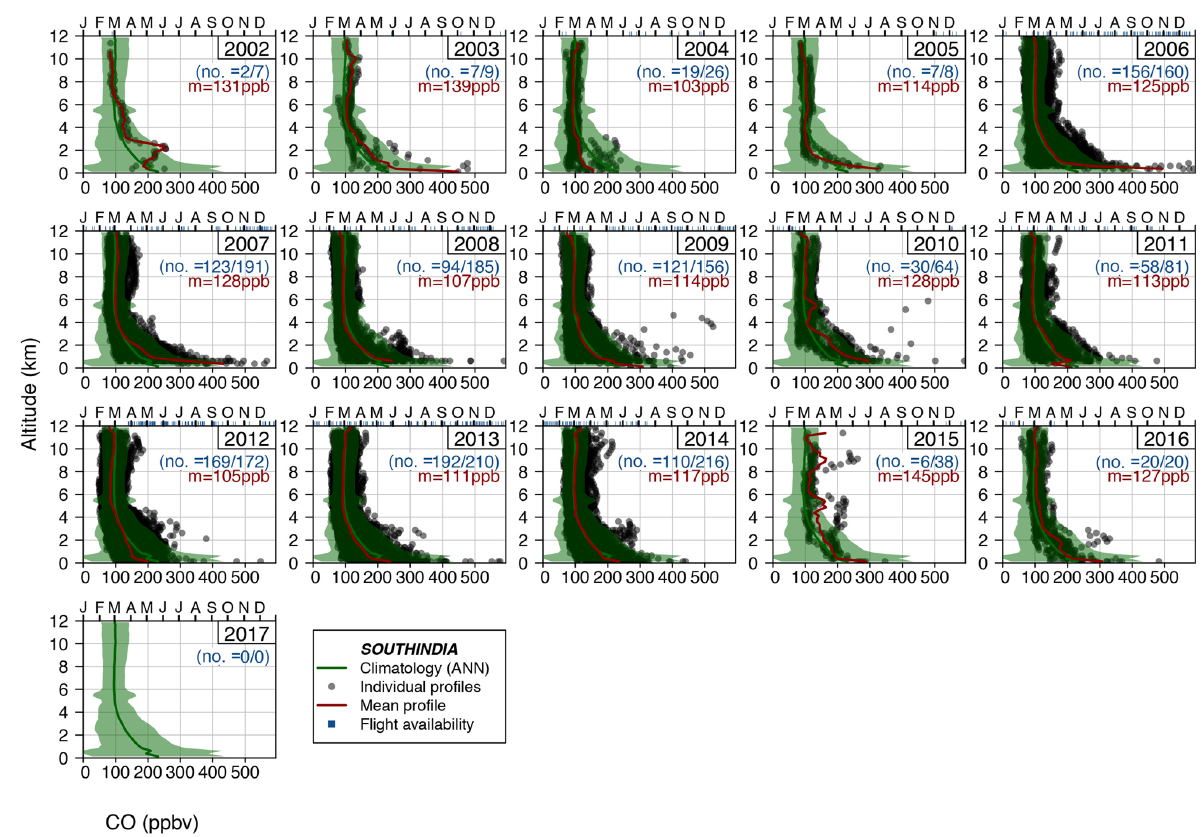
Figure 10. Same as Fig. 6 at the SouthIndia